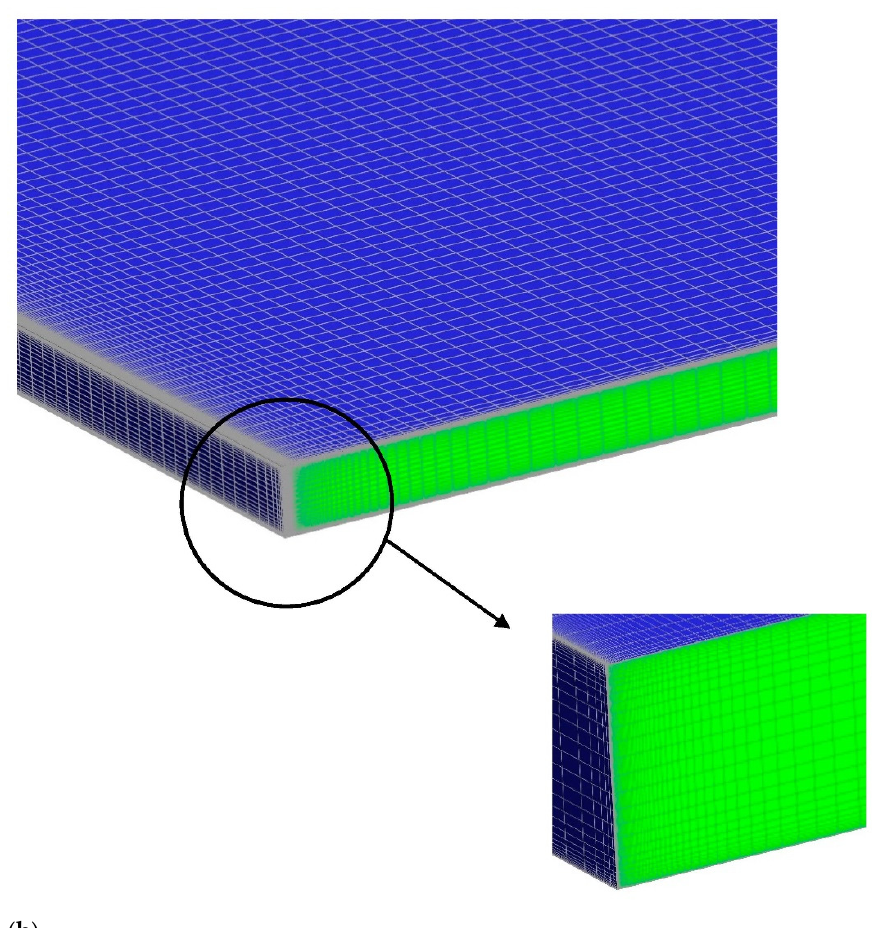
Figure 3. ( a ) geometrical model and boundary locations ( b ) mesh of the computational model.